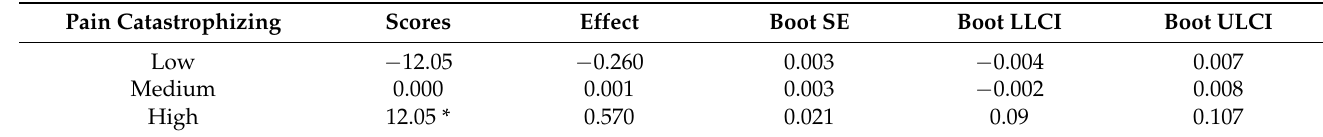
Table 4. The conditional effects of pain catastrophizing levels on pain perception via the preference for pain-avoidance goals.